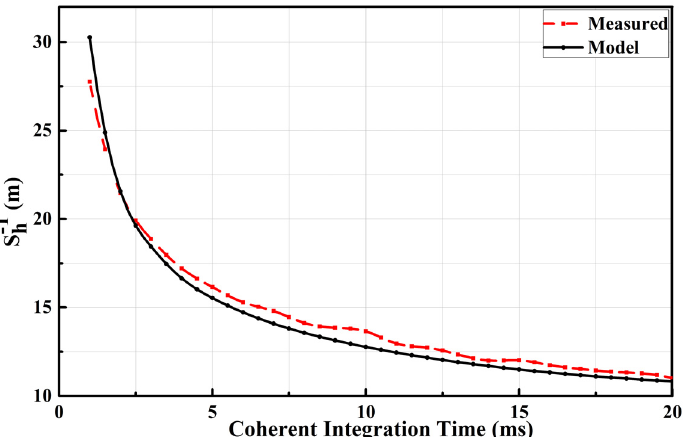
Figure 6. A comparison of the reciprocal value of altimetric sensitivity between measured (red) and simulated data (black).